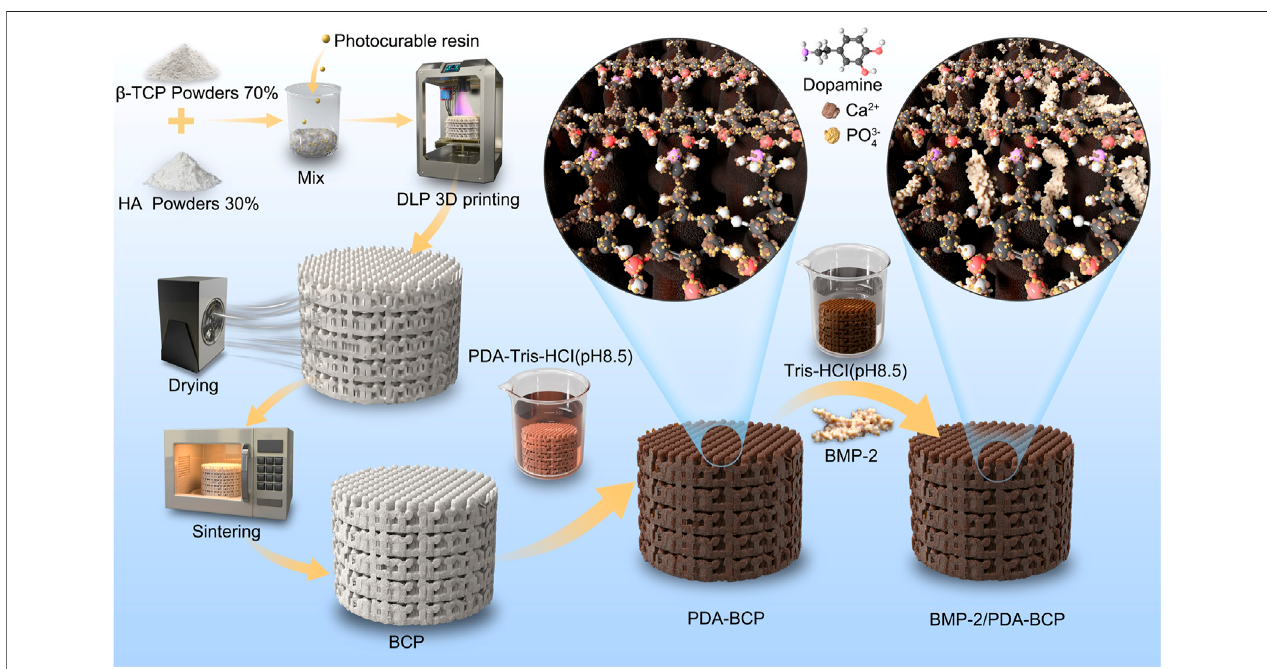
FIGURE 1 | Schematic diagram of DLP 3D printing, modi fi cation of PDA, and grafting of BMP-2. DLP: digital light processing; PDA: polydopamine; BMP-2: bone morphogenetic protein-2.